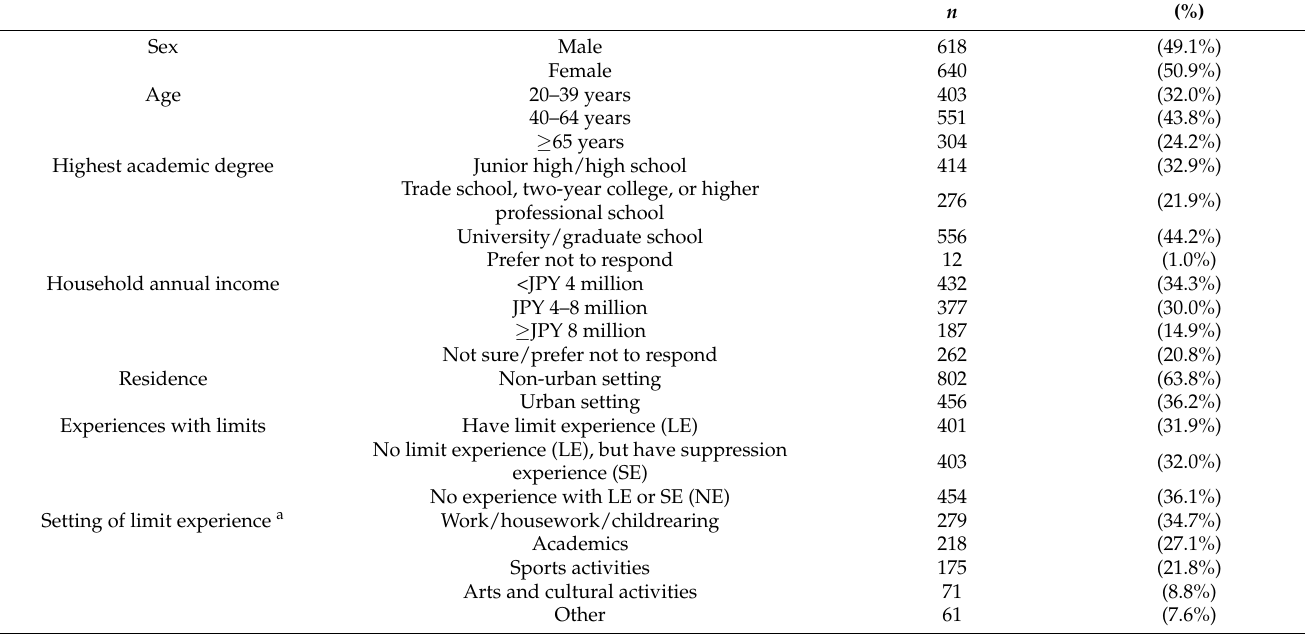
Table 1. Respondent characteristics and experiences with